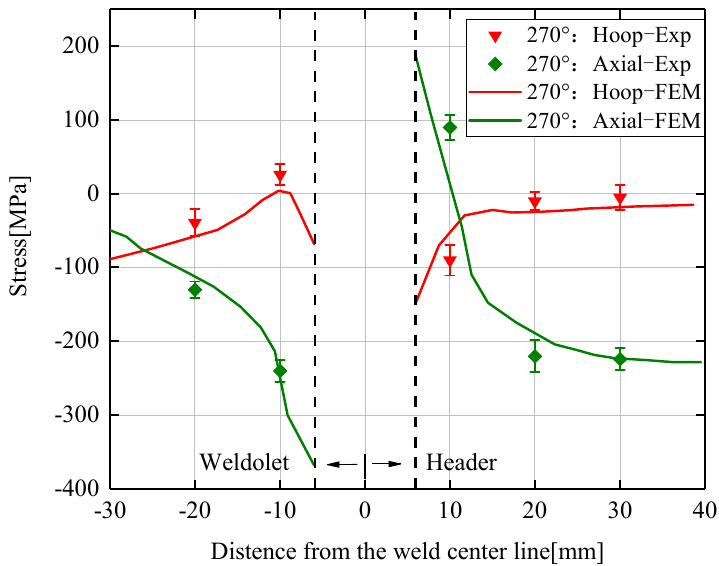
Figure 10. Comparison of experimental results and numerical simulation results of residual stresses.